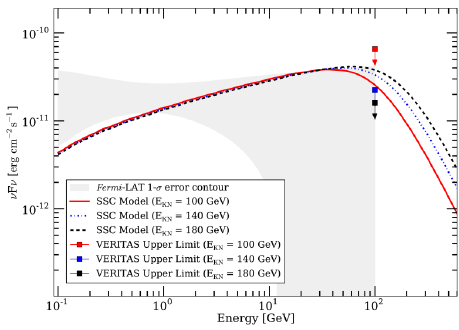
Figure 6. Combined Fermi -LAT spectrum including 1 σ confidence interval and VERITAS upper limits for the late afterglow of GRB 130427A. Reprinted with permission from Ref.